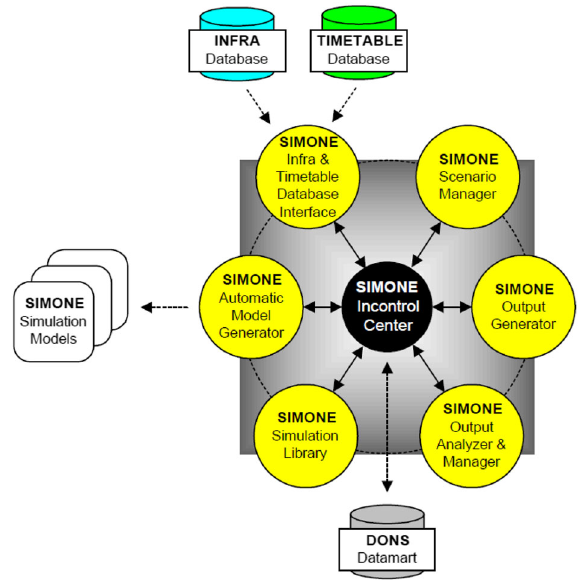
Fig. 3 SIMONE framework [3]